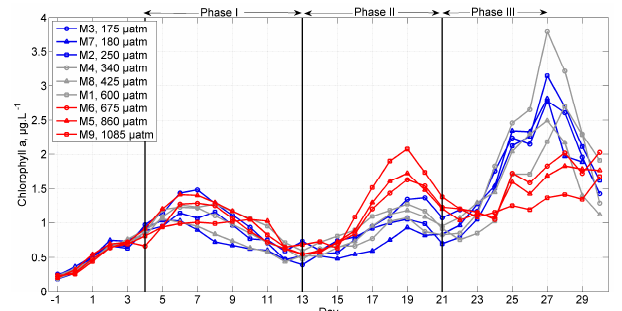
Figure 2 Fig. 2. Temporal evolution of chlorophyll a concentrations in dif- ferent mesocosms. Vertical lines on t 4 , t 13 and t 22 show the start and the end of each experimental phase. Blue colour of the lines indicates low p CO 2 level, grey – intermediate p CO 2 level and red – high p CO 2 level. Numbers in a legend next to every line with symbol are the rounded p CO 2 levels for t 8 – t 27